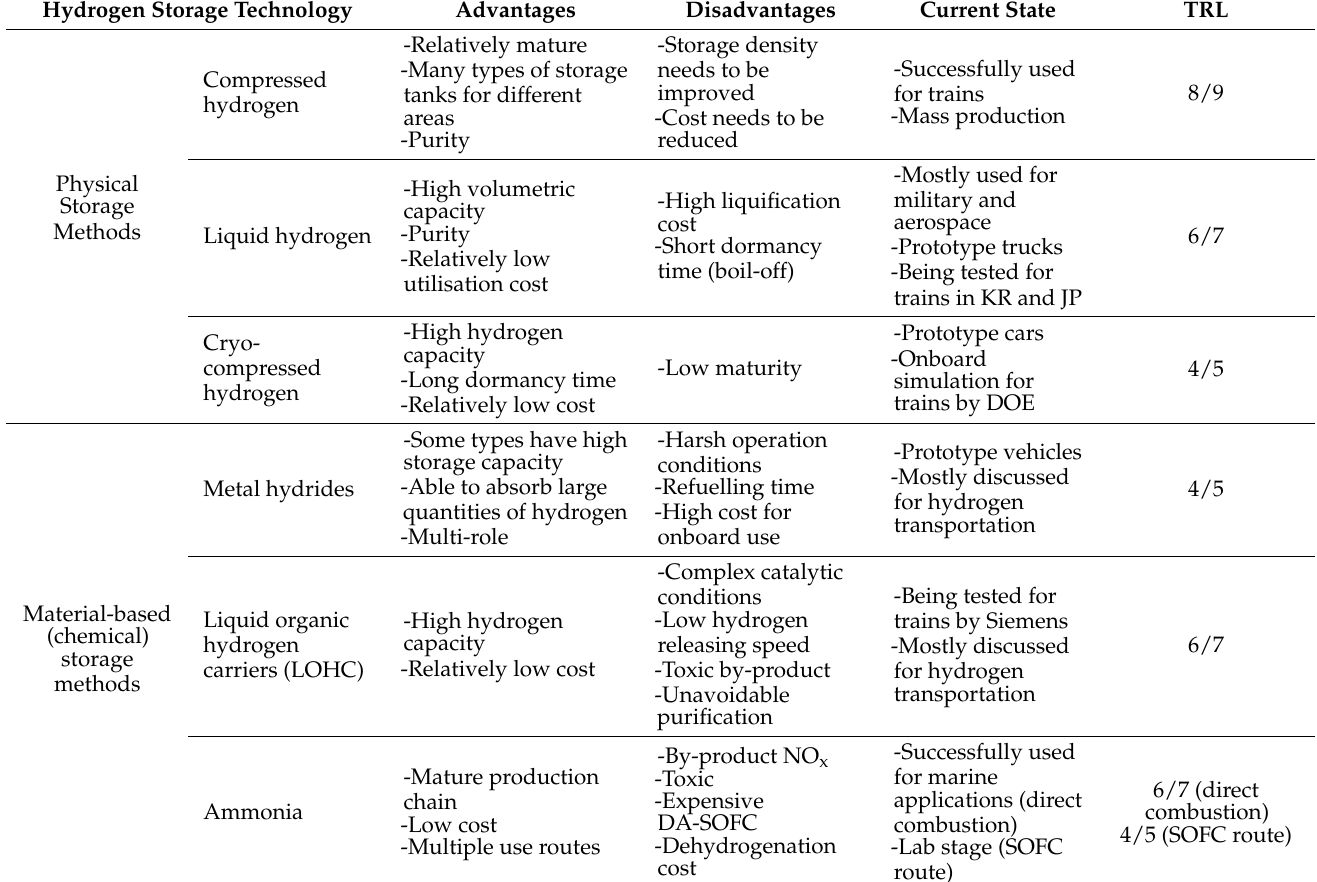
Table 10. Summary of different hydrogen storage technologies for onboard